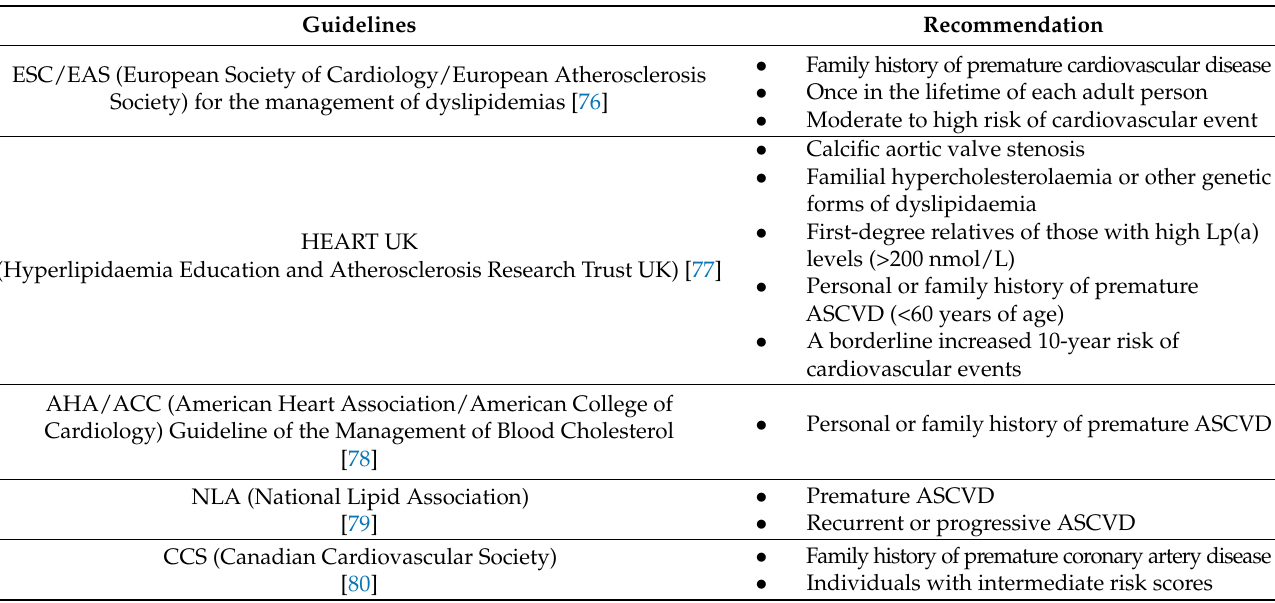
Table 2. Recommendation regarding the use of Lp(a) measurements in clinical